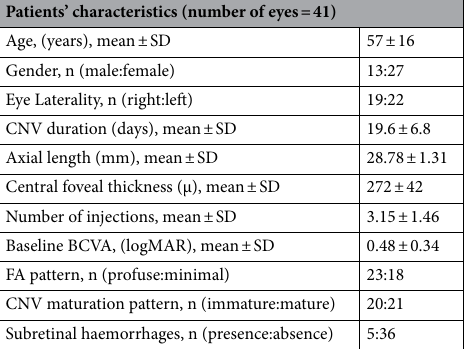
Table 1. Baseline demographic and clinical characteristics of study population. SD standard deviation, mm millimeter, BCVA best-corrected visual acuity, μ micron, CNV Choroidal neovascularization, logMAR logarithm of the minimal angle of